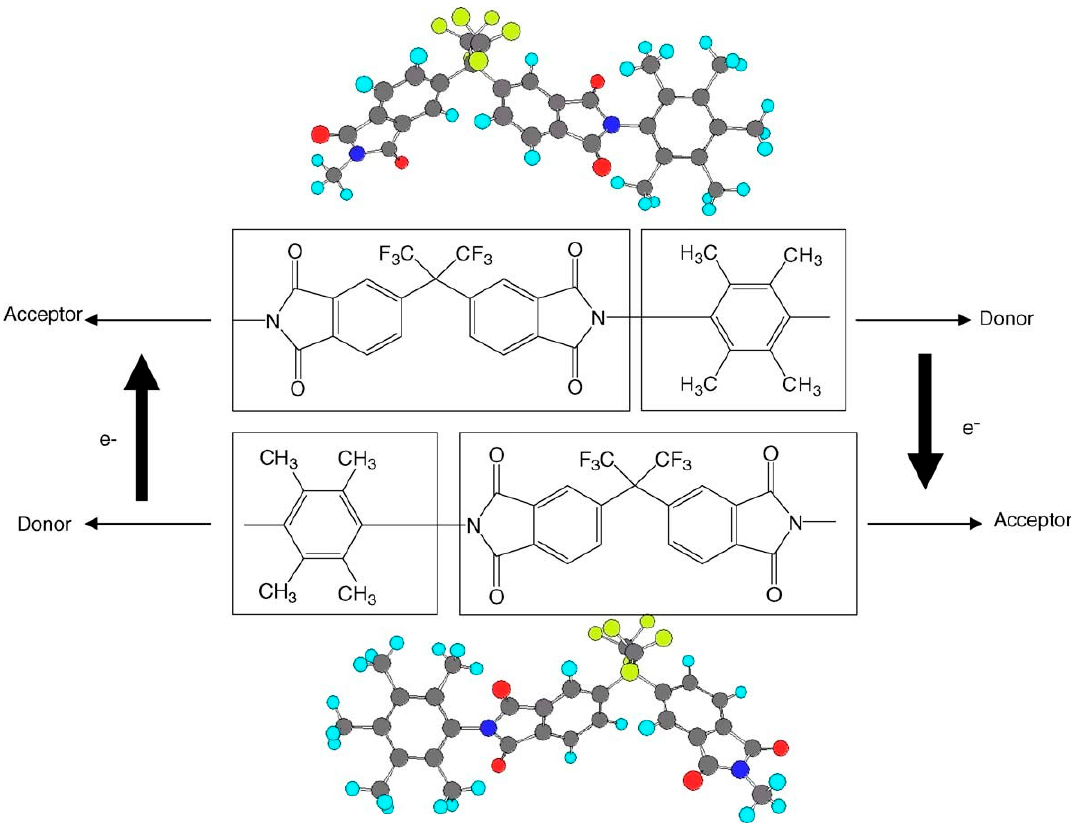
Figure 12 . Charge transfer complex model of 6FDA-durene polyimides [65]. Figure 12. Charge transfer complex model of 6FDA-durene polyimides